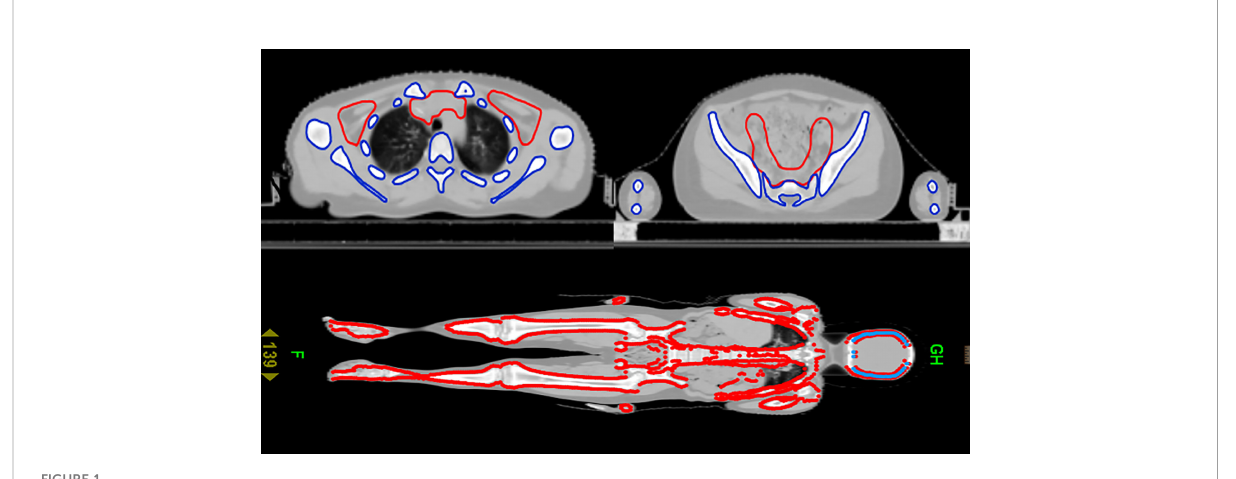
FIGURE 1 Cross-sectional and coronal display of the TMLI